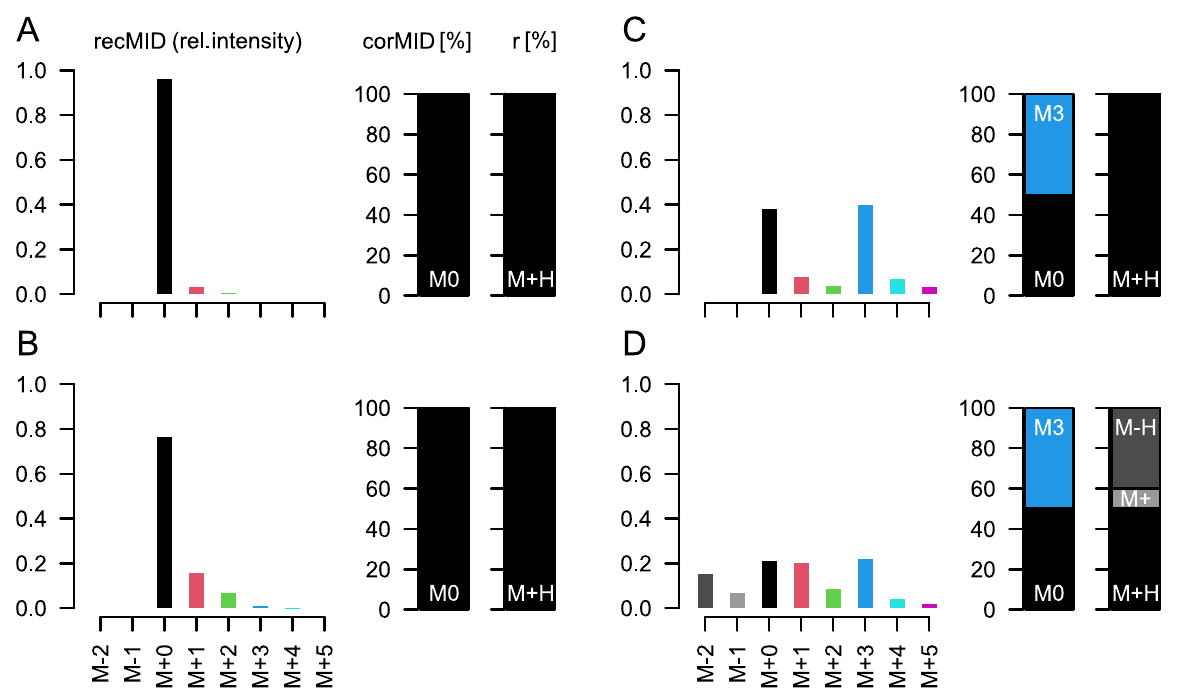
Figure 1. In situ demonstration of the problem of a superimposed MID. Each subpanel shows the relative measured intensities ( recMID , left ) of a compound reconstructed assuming a specific labelling state ( corMID , center) and a specific ion formation (fragment ratios r , right ). ( A ) For a compound with n = 3 carbon atoms, e.g., lactic acid, forming a single molecular ion ([M+H] + ) and showing only natural abundance of 13 C we would measure ion intensities at M+0 (which is the [M+H] + peak here) and at M+1 with approx. 3% intensity of M+0. Here, M represents the atomic mass of the molecular ion of the compound and the amended number indicates the total number of 13 C atoms contained in the specific MI. No 13 C from a tracer molecule is incorporated (M0 = 100%). In GC-APCI-MS, metabolites are usually silylated before analysis. The Si and C atoms incorporated during the silylation affect the recMID ( B ). If 50% of the lactic acid is fully (M3) labelled during a tracer experiment, recMID and corMID would be similar to the values presented in ( C ). ( D ) When effects such as proton loss (here, 10% of [M] + and 40% of [M-H] + ) are present, the recMID becomes more complex even for a simple corMID consistent with ( C